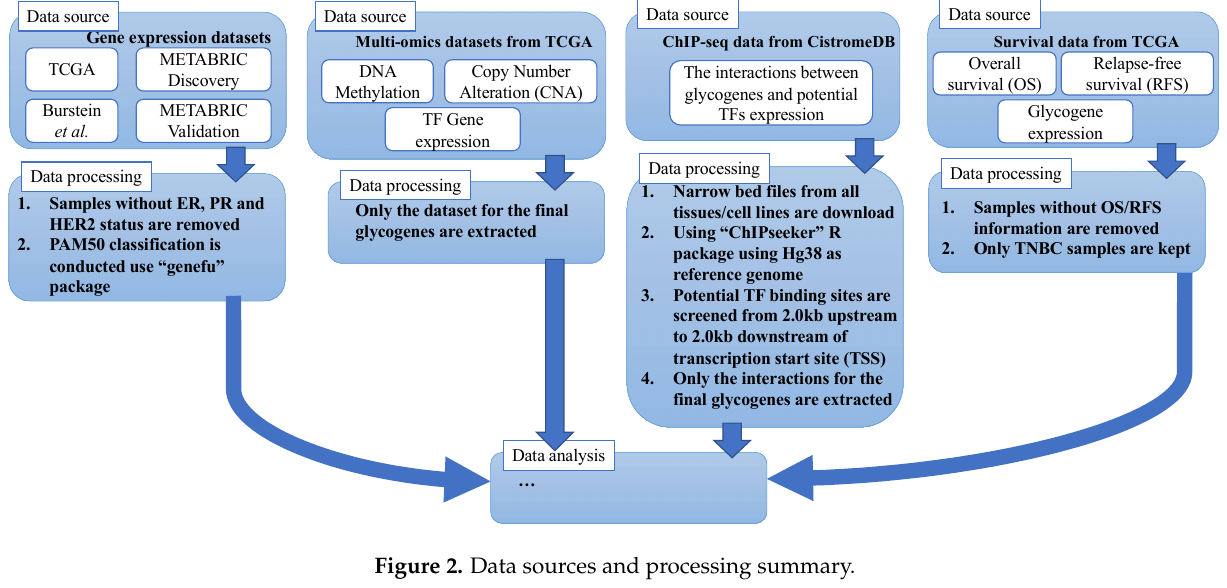
Figure 2. Data sources and processing summary.